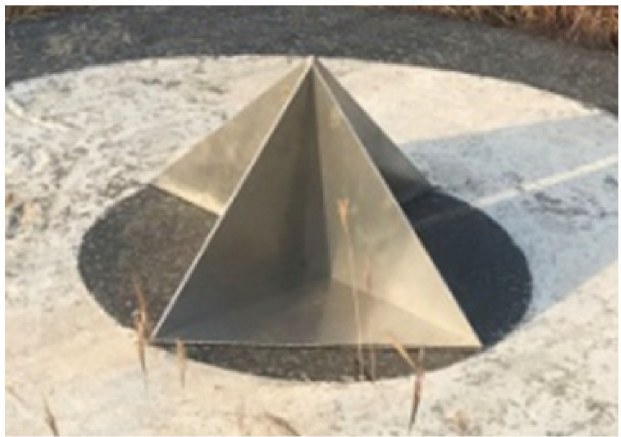
Figure 2. A metal corner reflector in the data acquisition